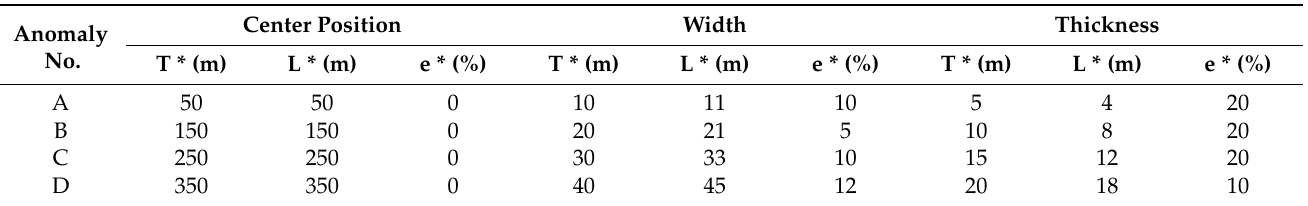
Table 5. Comparing the dimension and position of the four local anomalies shown on the land- streamer tomogram (Figure 9b) to those shown on the true model (Figure